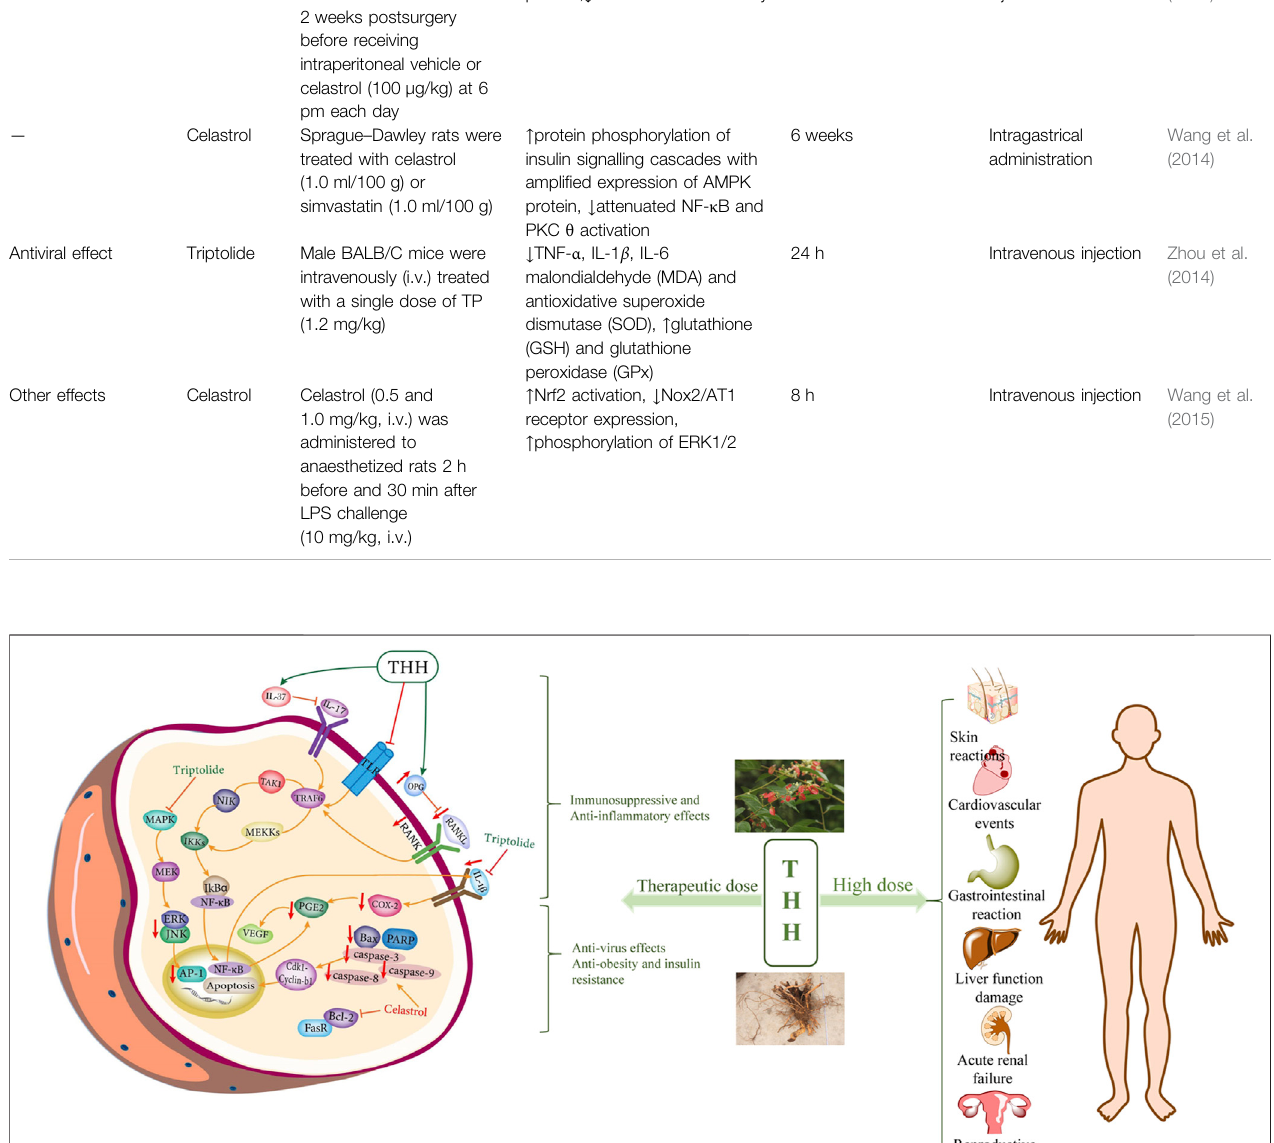
Frontiers in Pharmacology |